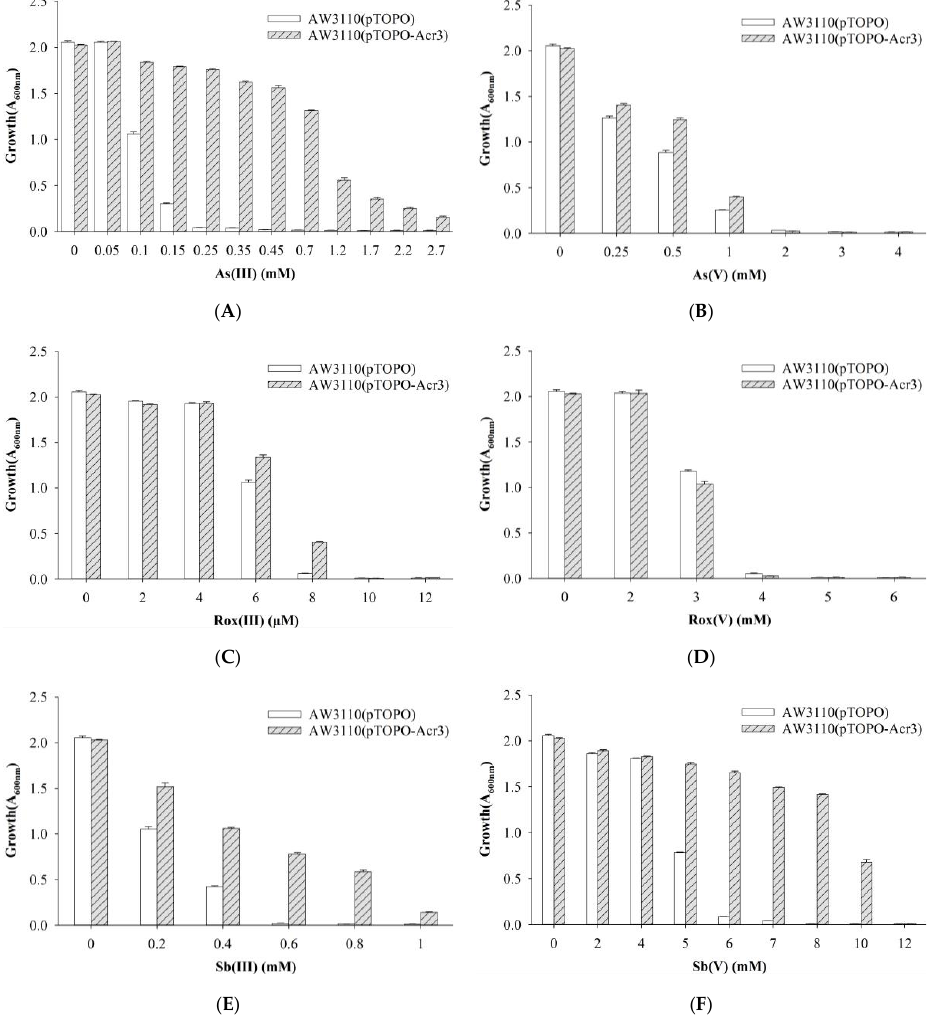
Figure 4. Growth of E. coli AW3110 bearing pTOPO and pTOPO-Acr3 with the indicated concentra- tions of As(III) ( A ), As(V) ( B ), Rox(III) ( C ), Rox(V) ( D ), Sb(III) ( E ), and Sb(V) ( F ). The A 600 nm was measured after 24 h of growth at 37 °C and 220 rpm. The graphs show the results of three replicates, and error bars represent the standard error of the average values.